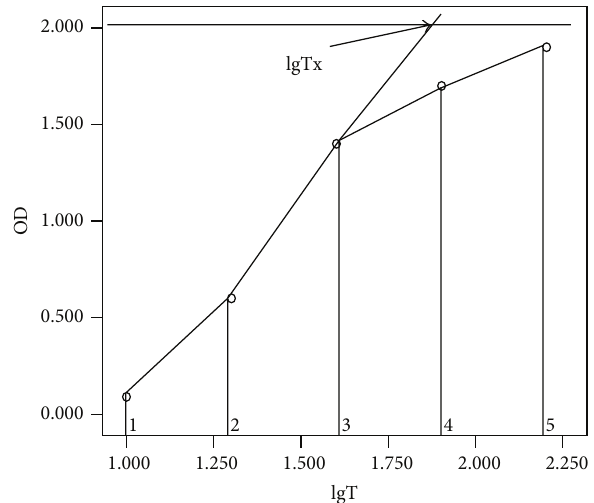
Figure 2: Schematic diagram for the calculation of serum antioxi- dant mass. lgTx represents the crossing point between lines of jump range and the blank control; lgTx value on the 𝑥 -axis represents the mass of antioxidants in the